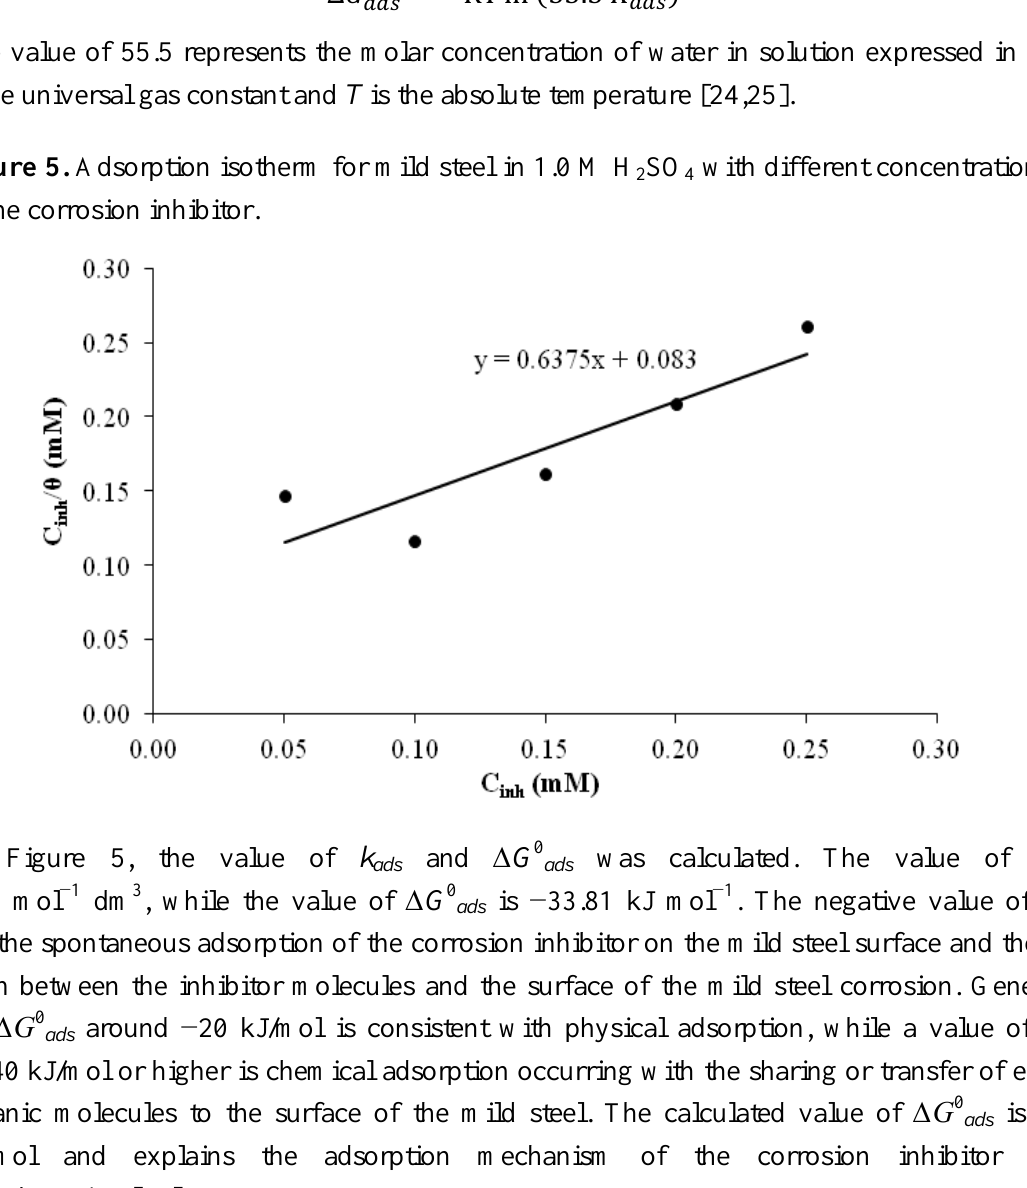
SO with different concentrations 2 4